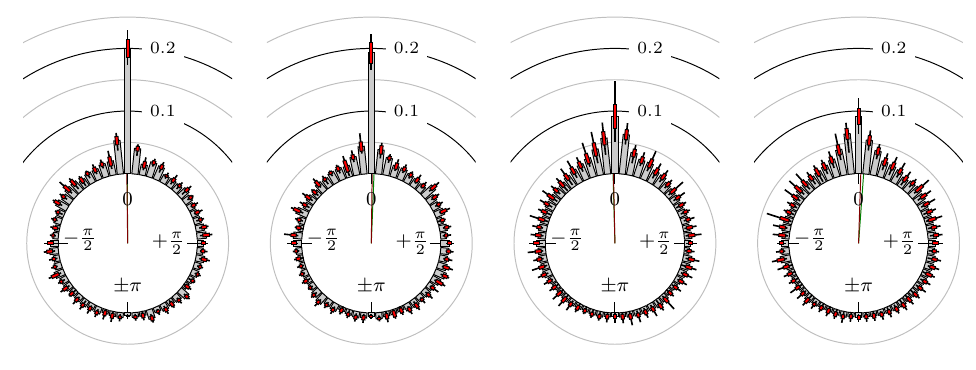
Figure 21. EUR-USD versus GBP-USD.